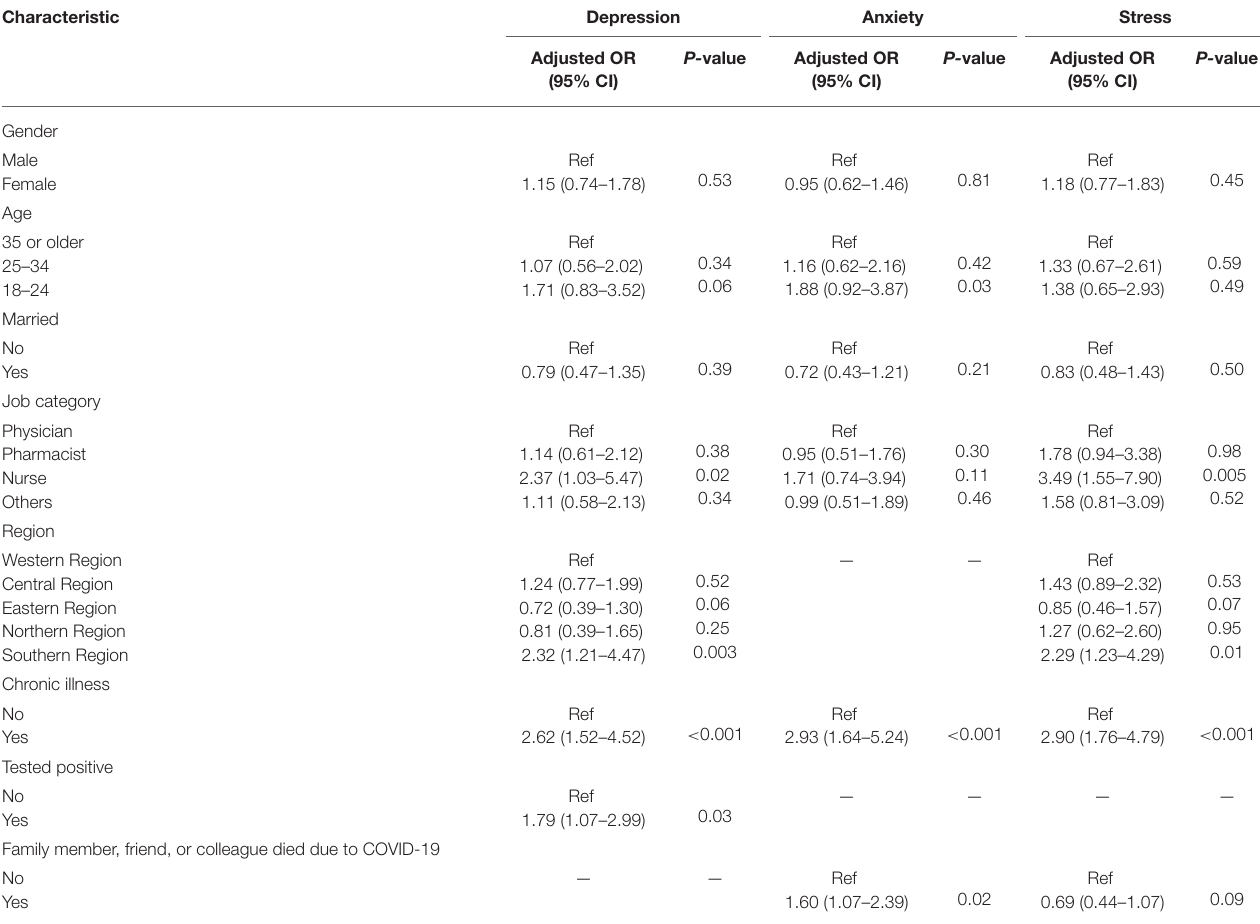
TABLE 3 | Multivariable logistic regression analysis of depression, anxiety, and